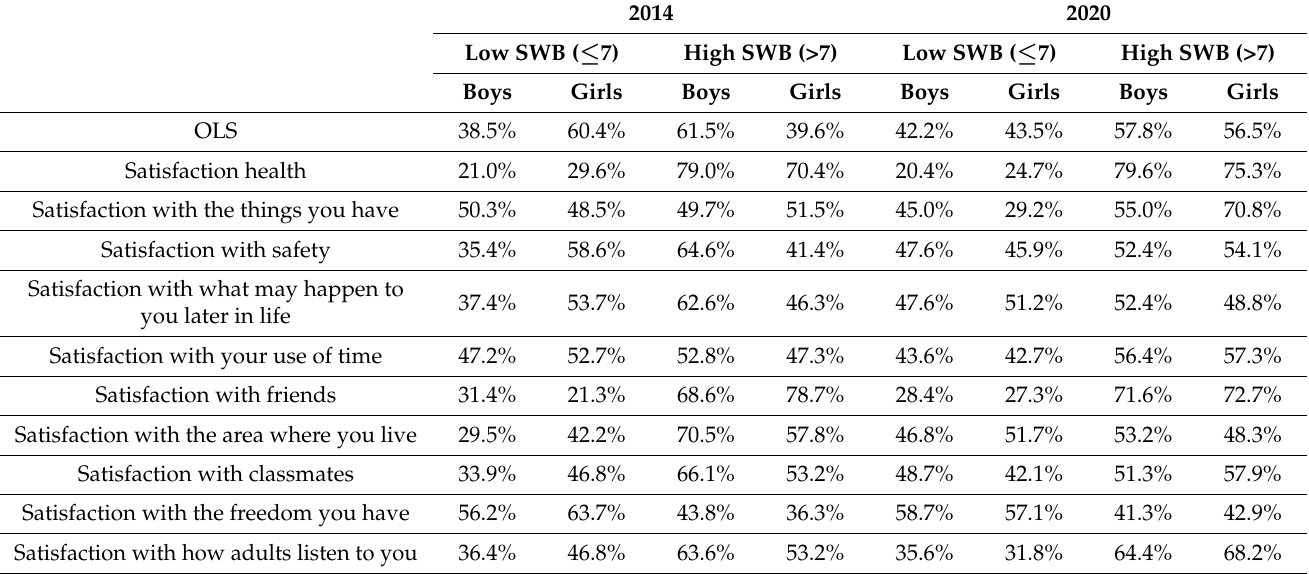
Table 2. Proportion (%) of participants who reported low and high scores for different subjective well-being domains and for overall life satisfaction (OLS) by gender and year of data